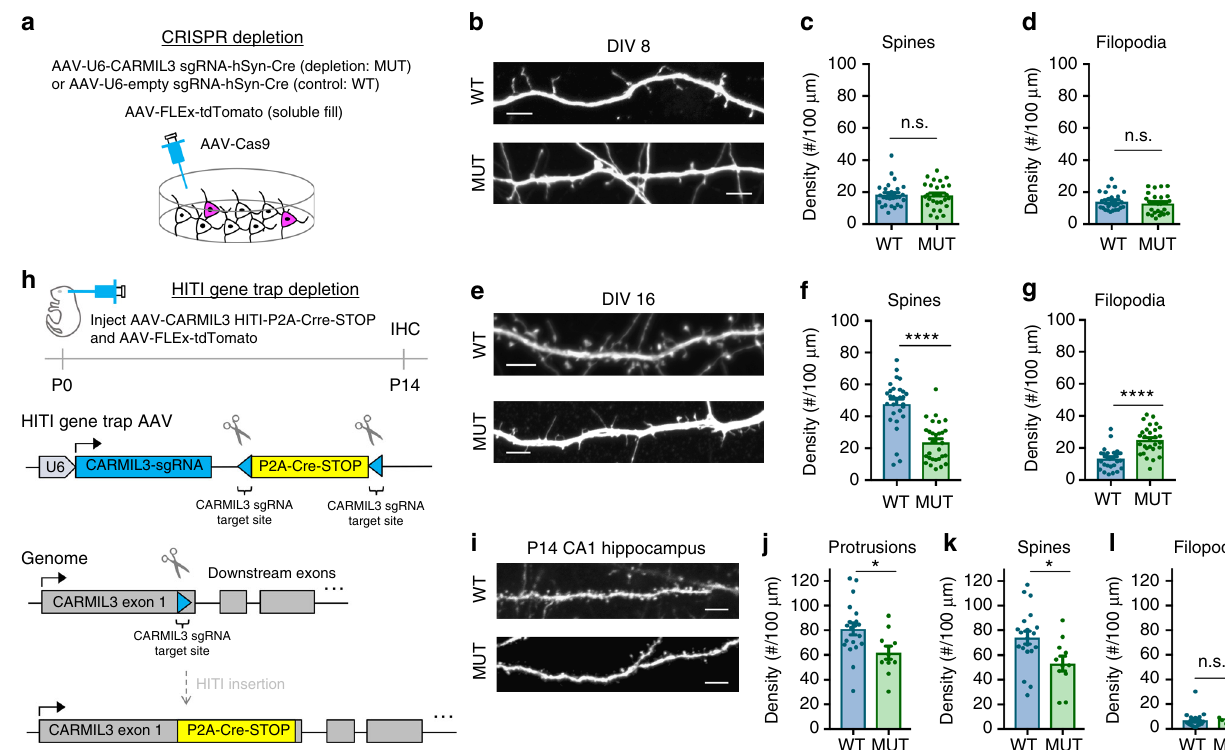
Fig. 5 CARMIL3 depletion causes alterations in dendritic spine maturation. a Schematic of CRISPR-based depletion strategy of CARMIL3 in cultured hippocampal neurons. b Representative images of control (WT) and CARMIL3-depleted (MUT) neurons at DIV8. Scale bars are 5 μ m. c Graphical representation of dendritic spine density for WT (18 ± 1 spines, n = 28 neurons) and MUT (18 ± 2 spines, n = 28 neurons) neurons at DIV8. p = 0.8235. d Graphical representation of fi lopodia density for WT (14 ± 1 fi lopodia, n = 28 neurons) and MUT (13 ± 1 protrusions, n = 28 neurons) neurons at DIV8. p = 0.4541. e Representative images of WT and MUT neurons at DIV16. Scale bars are 5 μ m. f Graphical representation of dendritic spine density for WT (48 ± 2 spines, n = 29 neurons) and MUT (24 ± 2 spines, n = 29 neurons) neurons at DIV16. p <0.0001. g Graphical representation of dendritic fi lopodia density for WT (13 ± 1 fi lopodia, n = 29 neurons) and MUT (25 ± 2 fi lopodia, n = 29 neurons) neurons at DIV16. p <0.0001. h Schematic of HITI gene trap strategy utilized for depleting CARMIL3 in vivo. i Representative images of tdTomato fi ll in WT and MUT pyramidal neurons at postnatal day 14 (P14) in hippocampal CA1. Scale bars are 5 μ m. j Graphical representation of dendritic protrusion density for WT (81 ± 5 protrusions, n = 20 neurons) and MUT (62 ± 5 protrusions, n = 11 neurons) neurons at P14. p = 0.018. k Graphical representation of dendritic spine density for WT (74 ± 5 spines, n = 20 neurons) and MUT (53 ± 6 spines, n = 11 neurons) neurons at P14. p = 0.018. l Graphical representation of dendritic fi lopodia density for WT (7 ± 1 fi lopodia, n = 20 neurons) and MUT (9 ± 2 fi lopodia, n = 11 neurons) neurons at P14. Error bars are standard error of the mean (SEM). p = 0.272. * p <0.05, ** p <0.01, **** p <0.0001, t